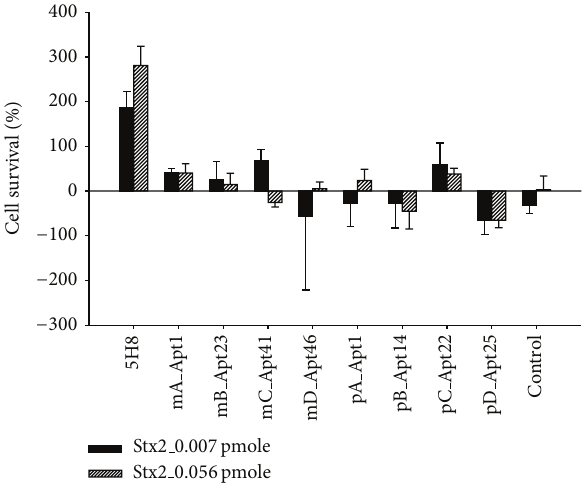
Figure 4: Neutralization of Stx2 activity by aptamers (1550pmoles) in HeLa cell cytotoxicity Assay. Stx2-specific HuMAb 5H8 (6.66 pmole) strongly neutralized Stx2 activity at both toxin concentrations (0.007 pmole and 0.056 pmole). A limited neutralization of Stx2 activity was observed with aptamers mA Apt1 ( ∼ 40% cell survival), mB Apt23 ( ∼ 20% cell survival), and pC Apt22 ( ≤ 60% cell survival). Aptamer mC Apt41 neutralized 0.007 pmole of Stx2 ( ≤ 60% cell survival) but not 0.056 pmole of Stx2. None of the other aptamers neutralized the cytotoxic effects of Stx2. This experiment was repeated twice with similar